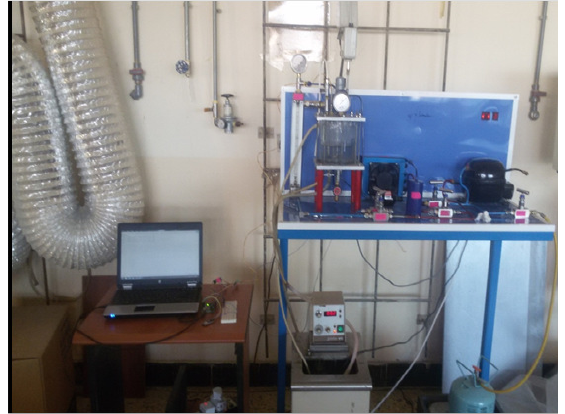
Fig. 4. The Apparatus .